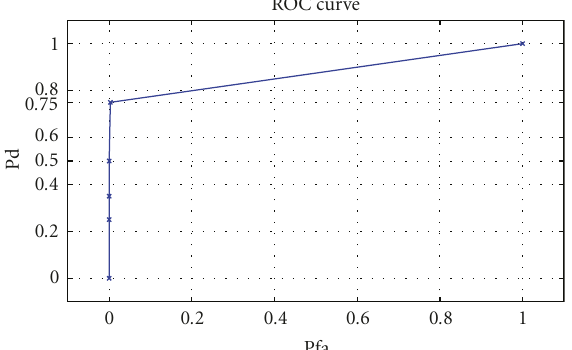
Figure 14: ROC curve for detection by spectrogram for SNR = 30db.